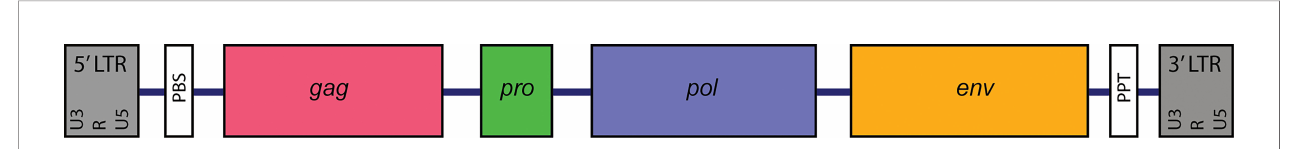
FIGURE 1 | Simpli fi ed schematic structure of the organization of a complete ERV. LTR, long terminal repeat control ERV transcription and polyadenylation; gag , viral capsid ; pol, reverse transcriptase , env, glycoprotein of the envelope ; pro, viral protease; PBS, tRNA-speci fi c primer-binding site; PPT, polypurine